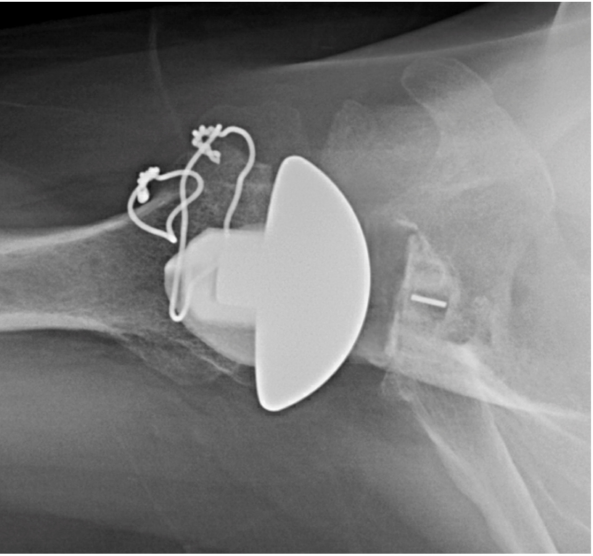
Figure 4. Inlay glenoid polyethylene in setting of glenoid dysplasia. Axillary X-ray of inlay glenoid polyethylene in setting of glenoid